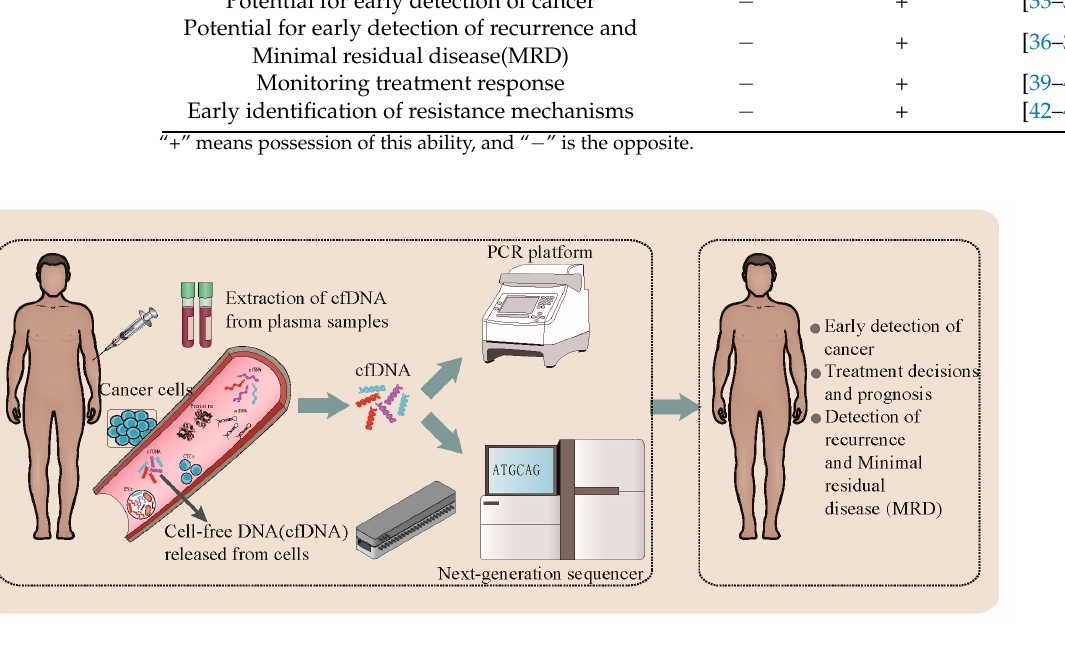
Figure 1. Clinical application of cell-free DNA (cfDNA) as liquid biopsy material.